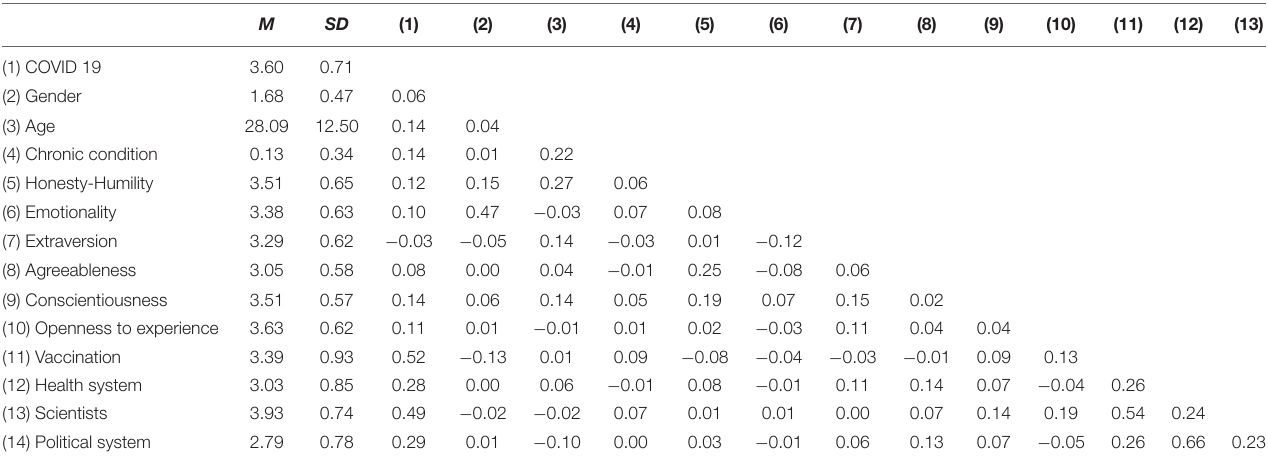
TABLE 1 | Descriptive statistics and correlations between the variables ( N = 1,700).